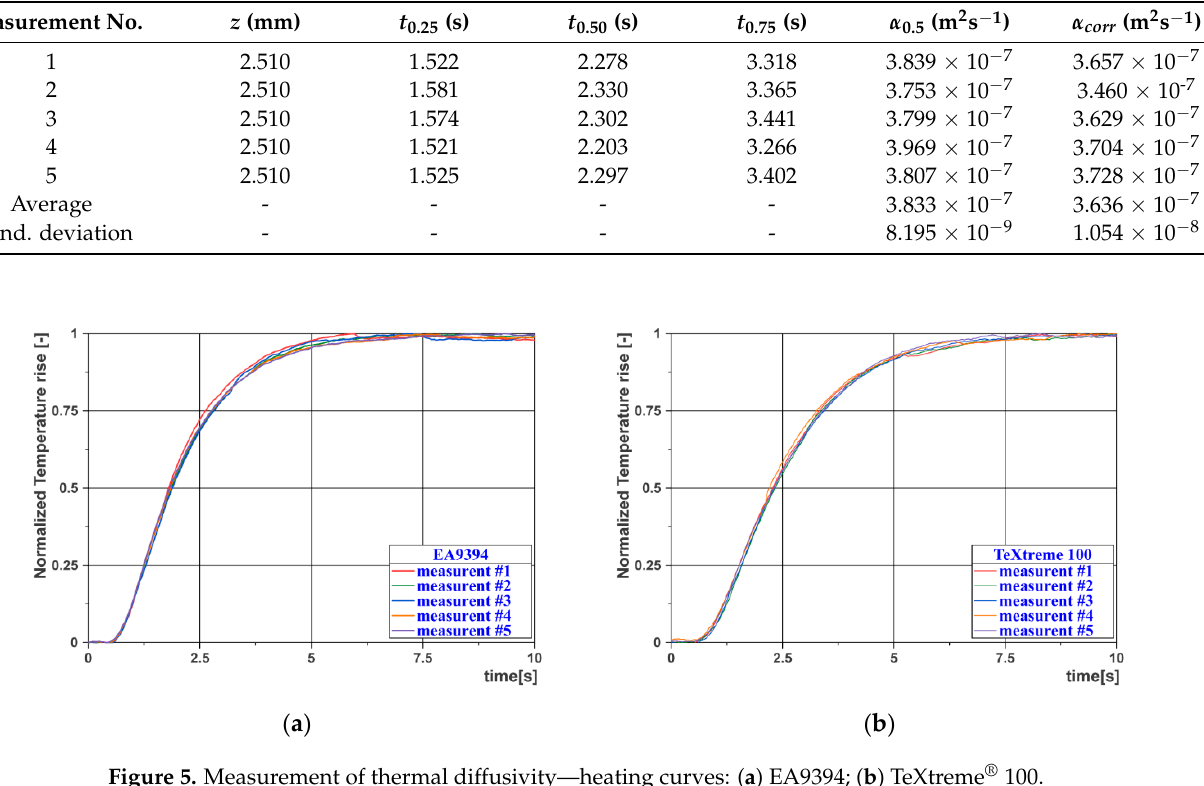
Table 3 . Thermal diffusivity—TeXtreme ® 100.